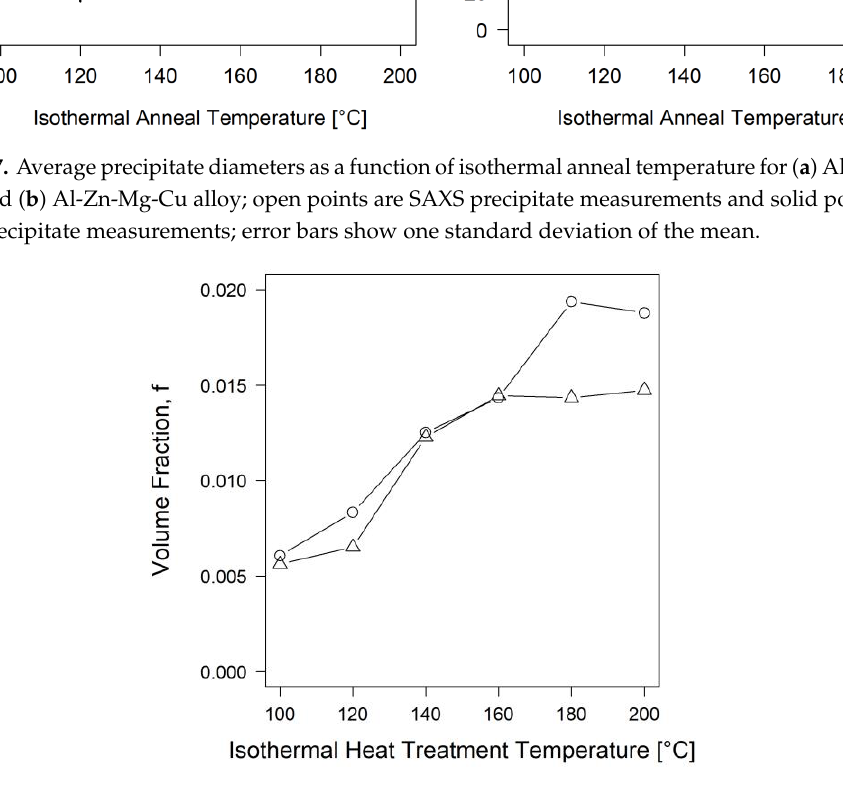
Figure 8. Calculated precipitate volume fraction for Al-Zn-Mg (triangles) and Al-Zn-Mg-Cu (circles) alloys after various 3 h isothermal heat treatments.